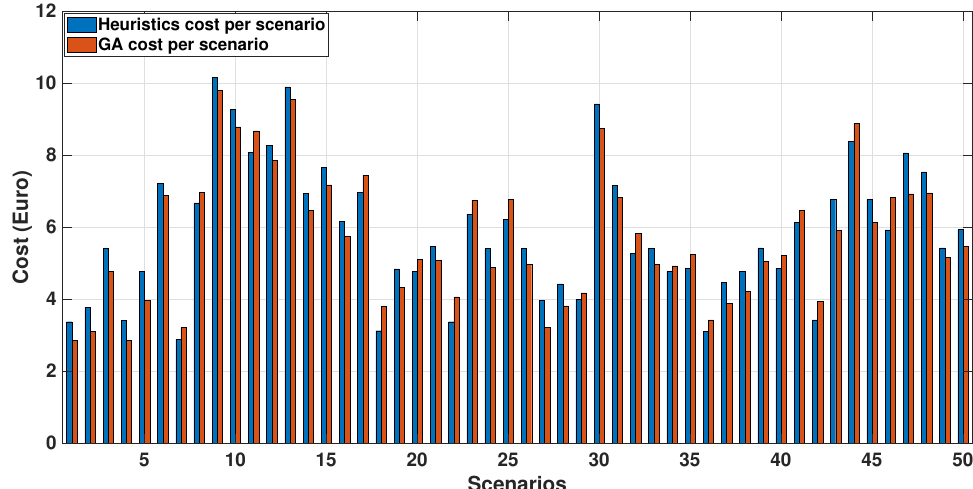
Figure 16. Heuristics and GA cost per scenario.